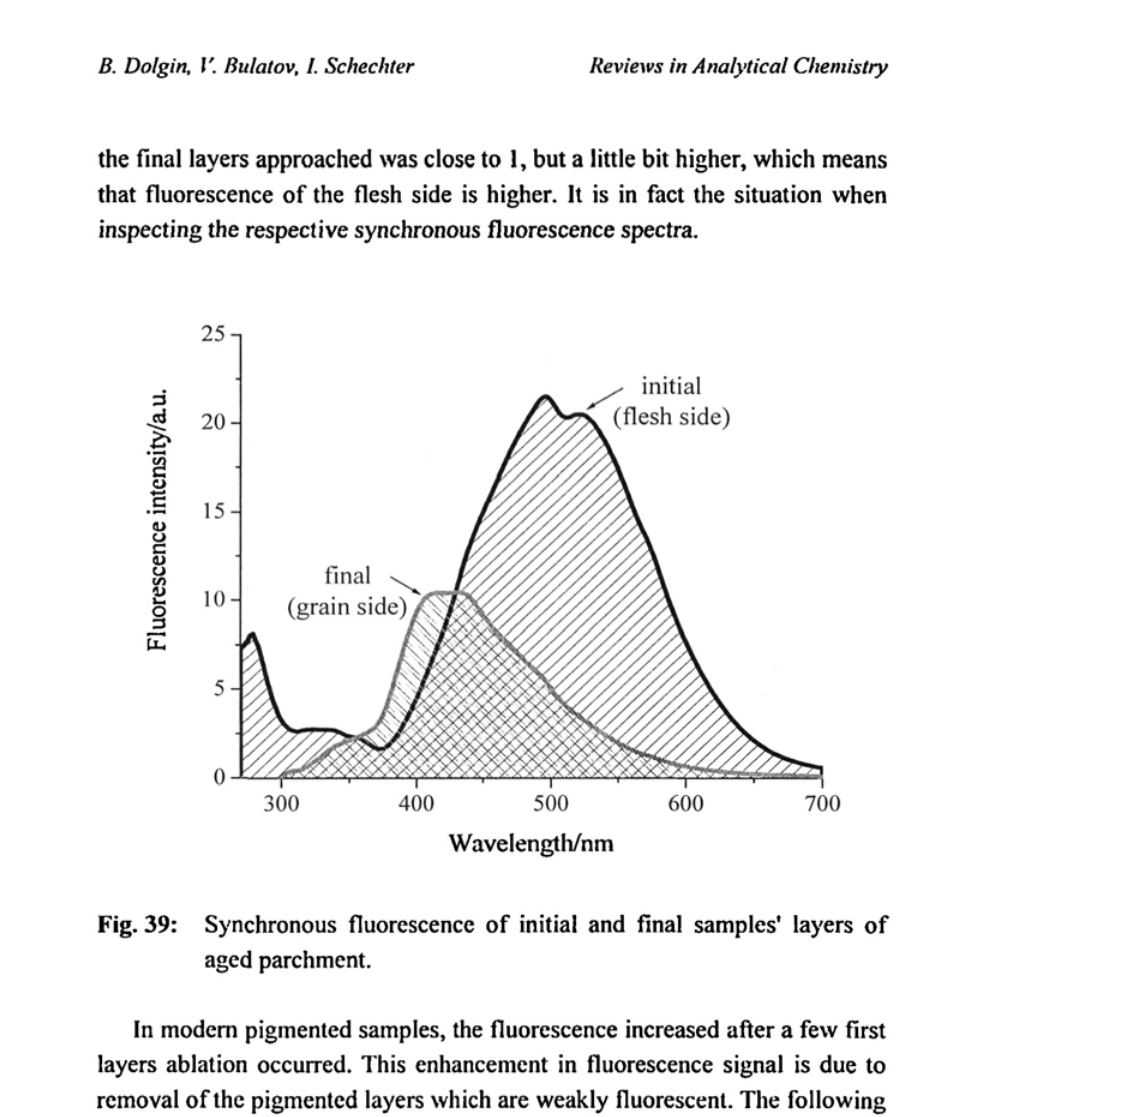
Fig. 39: Synchronous fluorescence of initial and final samples' layers of aged